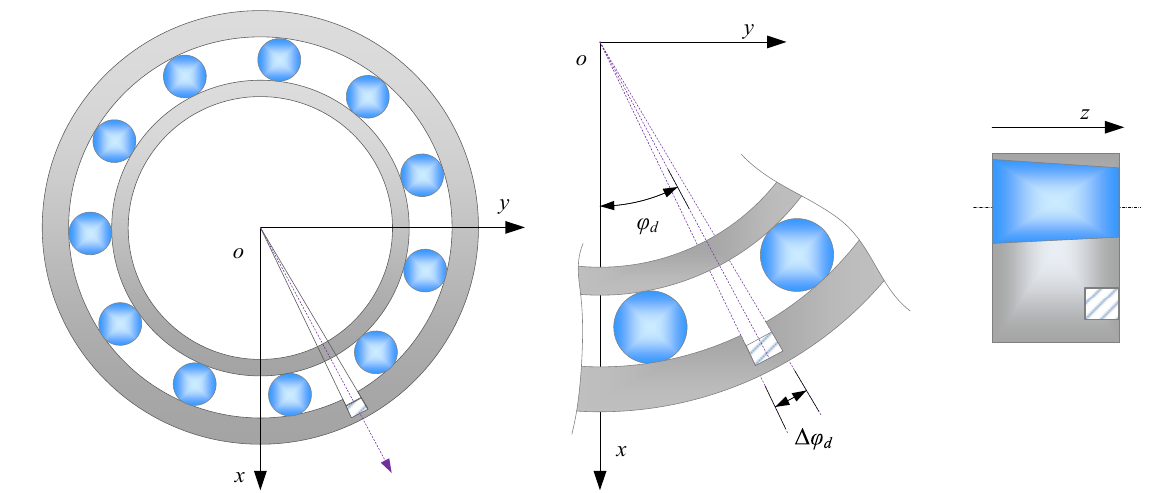
Figure 4. Schematic diagram of TRB with non-penetrating damage.